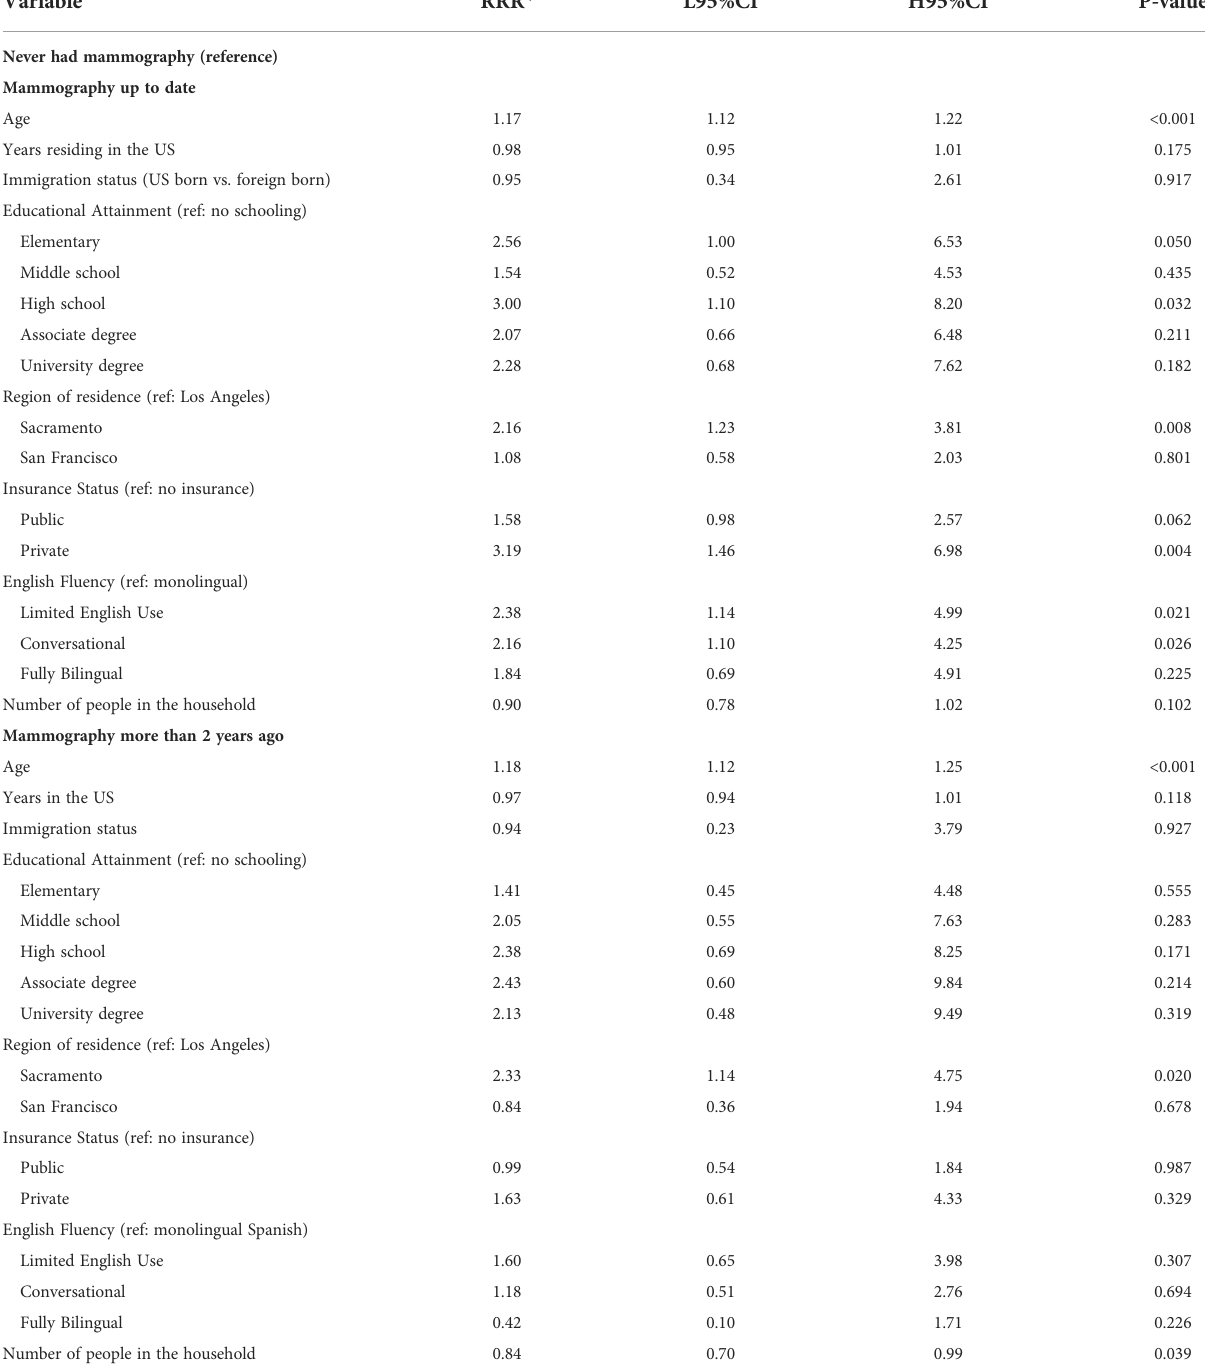
TABLE 4 Multivariate multinomial logistic regression model testing the association between breast cancer screening behavior and demographic factors among ‘ Tu Historia Cuenta ’ participants ages 40 to 74 (N=587, 42 excluded from 629 due to missing data). Variable RRR* L95%CI H95%CI